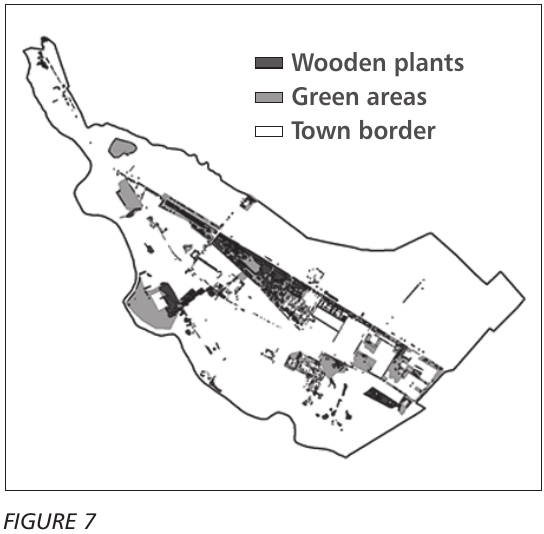
Wooden plants Green areas Town border